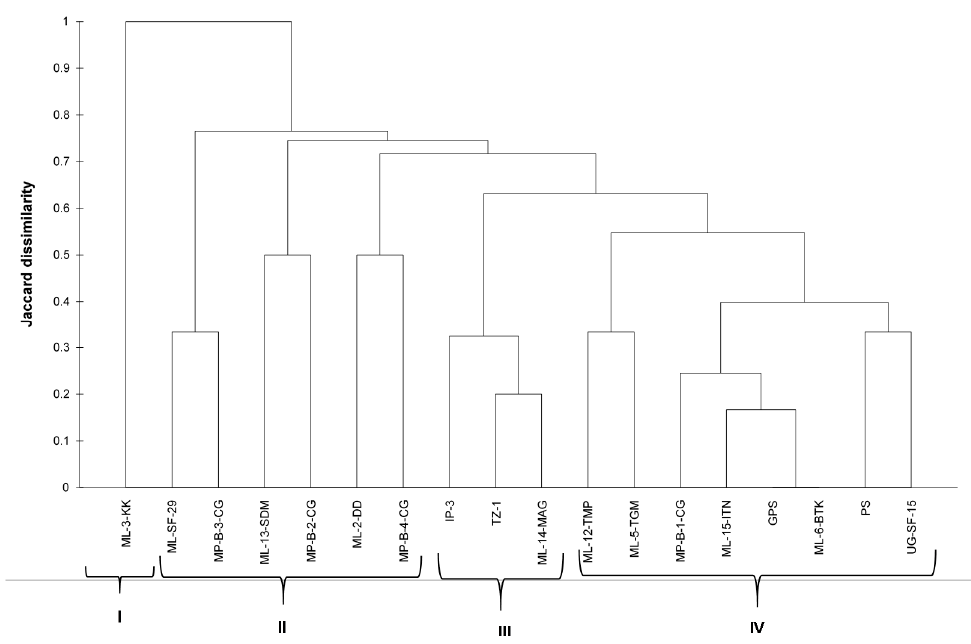
Figure 2. Dendrogram (unweighted pair group method with arithmetic mean) showing the rela- tionship between 18 Spider plant accessions.